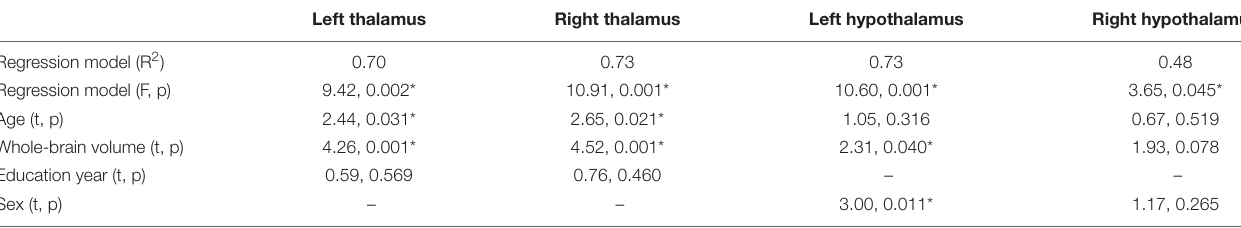
TABLE 4 | Multiple linear regression of brain volumes and clinical characteristics in controls.